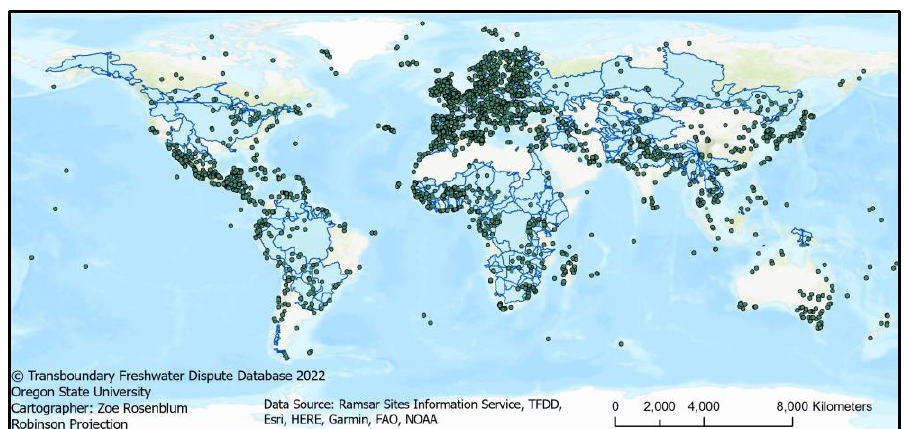
Figure 1. Ramsar Sites are designated in World map with international river basins (blue shading with dark blue outline) and Ramsar Sites (green points). This map was created in ArcGIS Pro using the Ramsar Sites Information Service and the Transboundary Freshwater Diplomacy Database spatial files of 312 international river basins.